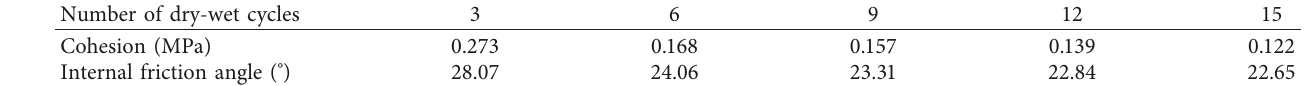
Table 6: Strength parameters under different dry-wet cycles at 105 ° C.